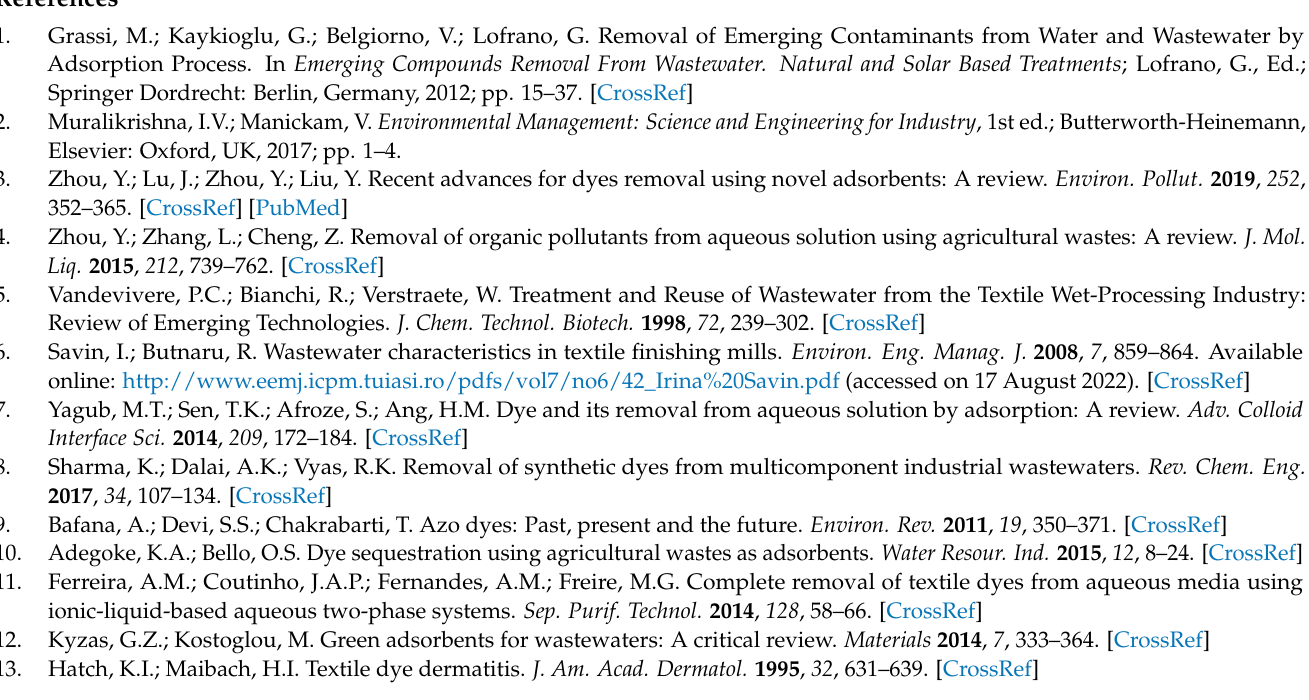
zeolites at two temperature; Table S3: Characterization of zeolites; Figure S1: Functional dependence ln x/m of ln γ e for the suspension RB-NH 4 BETA at 283 K; Figure S2: Functional dependence ln x/m of ln γ e for the suspension RB-NH 4 BETA at 293 K; Figure S3: Functional dependence ln x/m of ln γ e for the suspension RB-NH 4 ZSM-5 at 283 K; Figure S4: Functional dependence ln x/m of ln γ e for the suspension RB-NH 4 ZSM-5 at 293 K; Figure S5: Functional dependence ln x/m of ln γ e for the suspension RB-NaY at 283 K; Figure S6: Functional dependence ln x/m of ln γ e for the suspension RB-NaY at 293 K; Figure S7: Functional dependence ln x/m of ln γ e for the suspension MB-NH 4 BETA at 283 K; Figure S8: Functional dependence ln x/m of ln γ e for the suspension MB-NH 4 BETA at 293 K; Figure S9: Functional dependence ln x/m of ln γ e for the suspension MB-NH 4 ZSM-5 at 283 K; Figure S10: Functional dependence ln x/m of ln γ e for the suspension MB-NH 4 ZSM-5 at 293 K; Figure S11: Functional dependence ln x/m of ln γ e for the suspension MB-NaY at 283 K; Figure S12: Functional dependence ln x/m of ln γ e for the suspension MB-NaY at 293 K; Figure S13: Degree of photolytic degradation of RB and MB dye under the UV radiation at two temperatures after 180 min radiation; Figure S14: Calibration curve of MB dye; Figure S15: Calibration curve of RB dye; Figure S16: FT-IR spectra NH 4 BETA zeolite; Figure S17: FT-IR spectra NH 4 ZSM-5 zeolite; Figure S18: FT-IR spectra NaY zeolite; Figure S19: Calibration curve for determination of